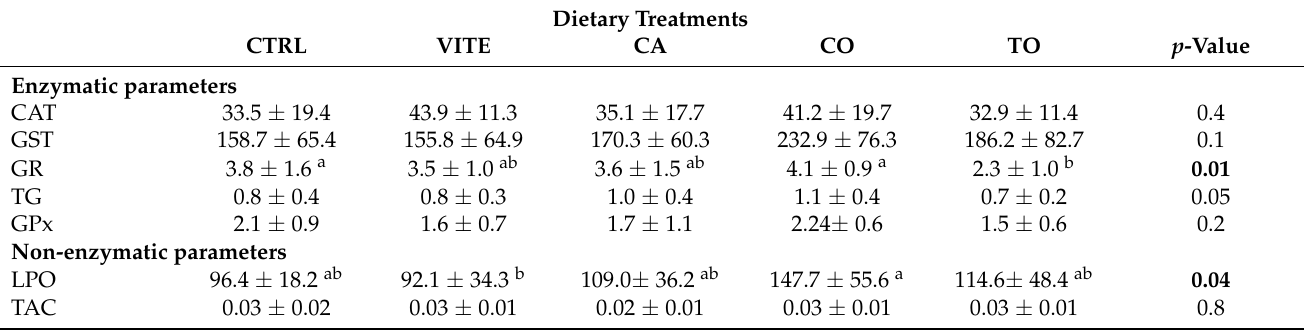
Table 6. Enzymatic/non-enzymatic parameters in Dicentrarchus labrax liver. Dietary